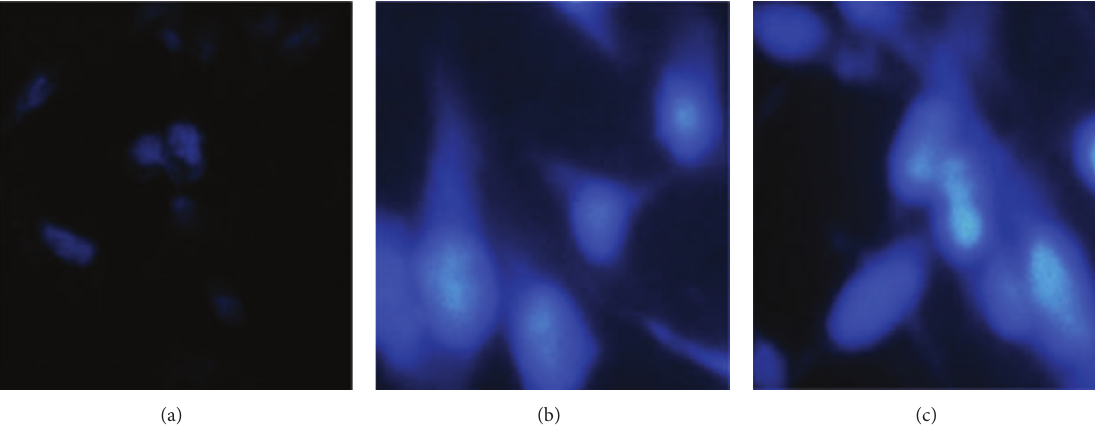
Figure5:Hoechst33342stainingofuntreatedcontrolcells(a)versus0.1 mmol/L(b)and1mmol/L(c)VPAtreated8305Ccells.Afterexposure to VPA for 96 h, fresh dilution of the Hoechst 33342 stock solution was added with the final concentration of 1 𝜇 g/mL, incubated at 37 ∘ C for 15 minutes, protected from light. The stained cells were examined by IX70 fluorescence microscope using blue filter (excitation, 350 nm; emission, 450 nm) and photographed (magnification